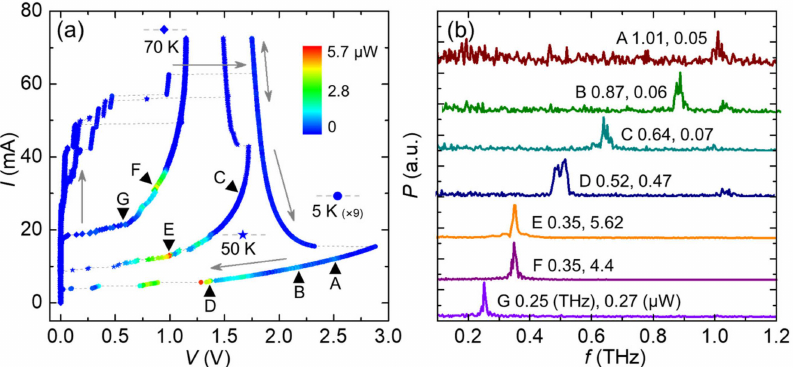
Figure 2. ( a ) Transport and terahertz emission characteristics of the BSCCO stack at T b = 5 K, 50 K and 70 K. The gray arrows indicate the sweep direction of bias current for the 5-K curve. Colors indicate the emission power (multiplied by a factor of 9 for the T b = 5 K data) detected by the Golay cell. ( b ) Fourier spectra of the emission for the bias points A – G indicated in ( a ); the numbers next to the labels are the values of emission peak frequencies and emission power. The data in ( b ) are rescaled to yield similar heights of the emission